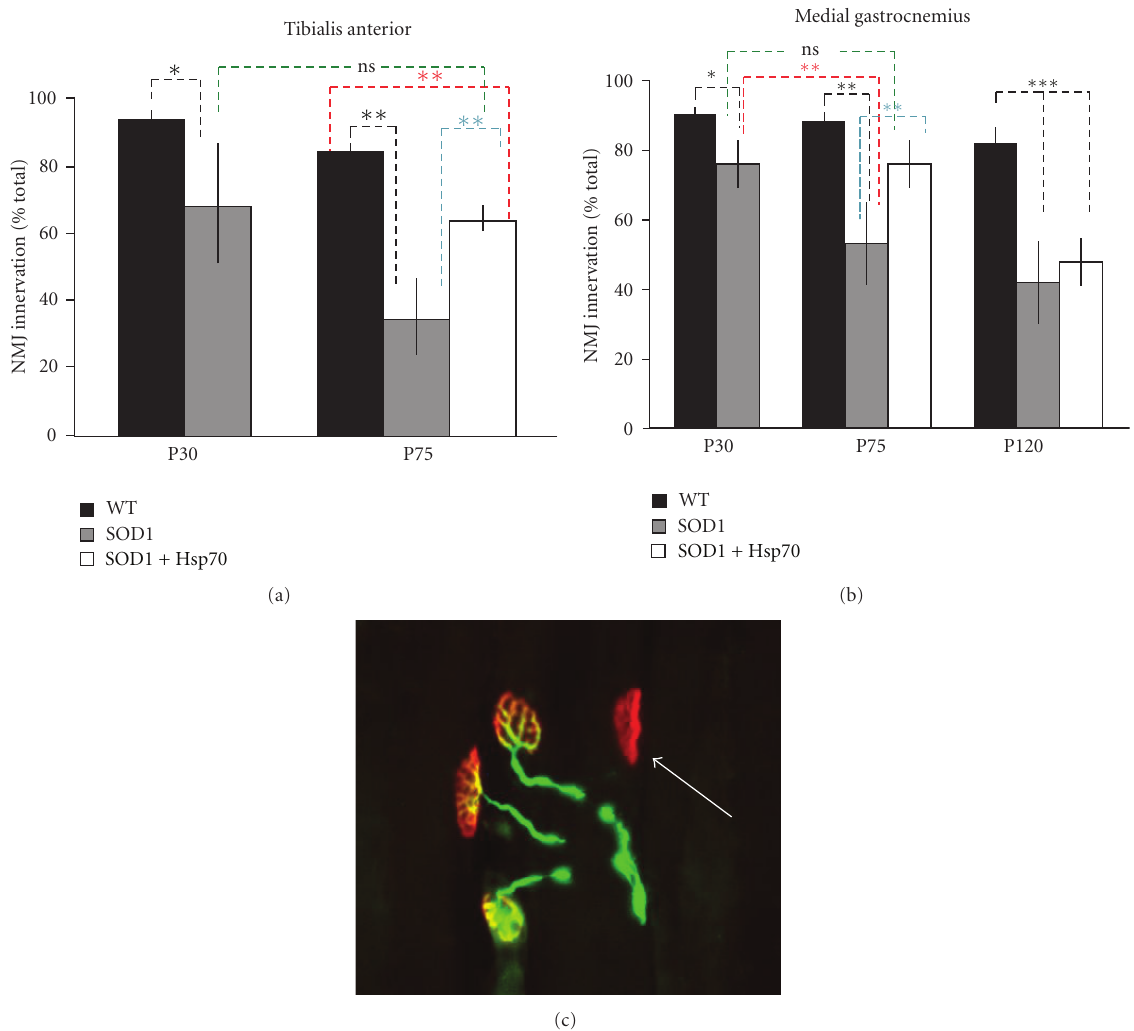
Figure 1: rhHsp70 injections maintain NMJ innervation. (a) Denervation of TA NMJs in SOD1 is evident by P30 and is further increased by P75. Treatment with rhHsp70 appeared to attenuate this denervation. Data are represented as percent of WT ± SEM at each time point. Statistical significance was determined by running an ANOVA, followed by the Tukey-Kramer multiple comparisons posthoc test ( ∗ P < 0 . 05; ∗∗ P ≤ 0 . 01 and ∗∗∗ P ≤ 0 . 001). (b) The MG in SOD1 mice displayed significant denervation at P30 and there is further denervation at P75 as compared to WT mice. rhHsp70 treatment maintained innervation of MG NMJs between P30 and P75. Statistical analysis was performed as described in (a) P30 WT TA n = 9; P30 SOD1 TA n = 8; all other groups n = 5. (c) Photomicrograph to illustrate criteria for innervated and denervated NMJs at P75. Colocalization of α BTX-labelled nAChR clusters (red) with VAChT and neurofilament-L nerve terminals (green) indicate innervated NMJs. The arrow denotes a denervated NMJ because of the lack of VAChT labeling.